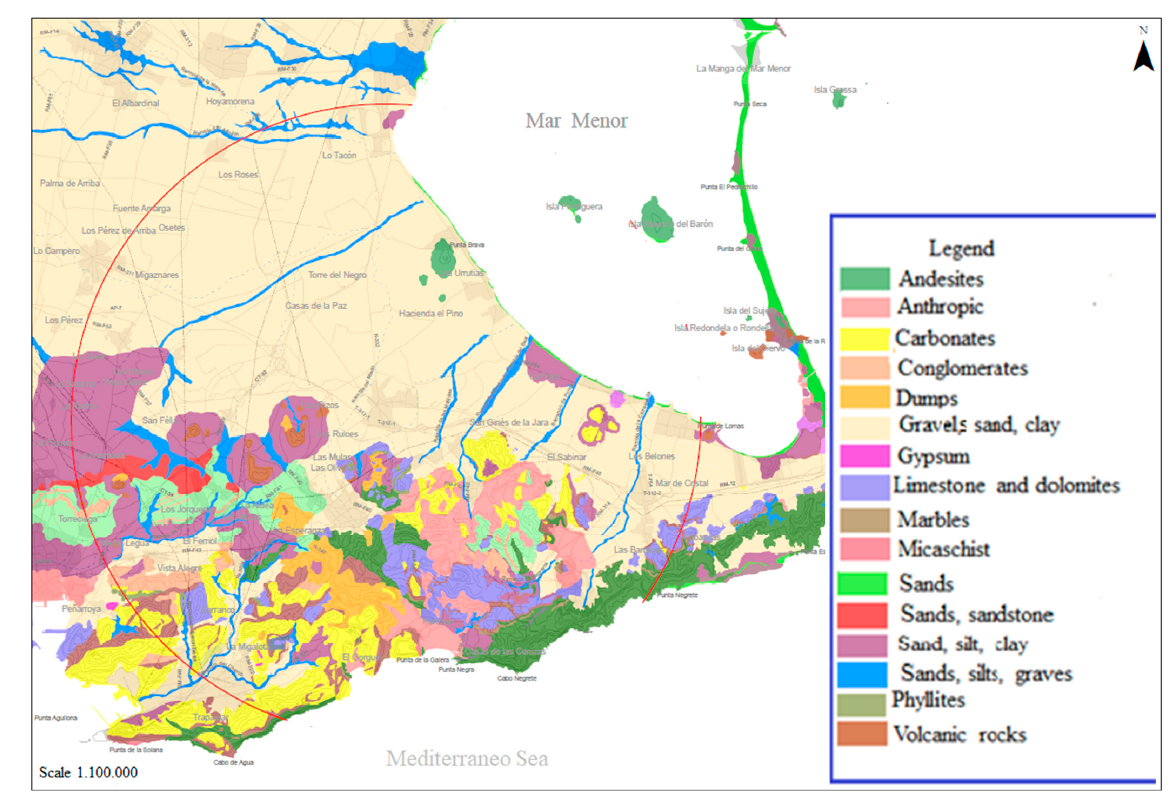
Figure 3. Lithology of the study zone.